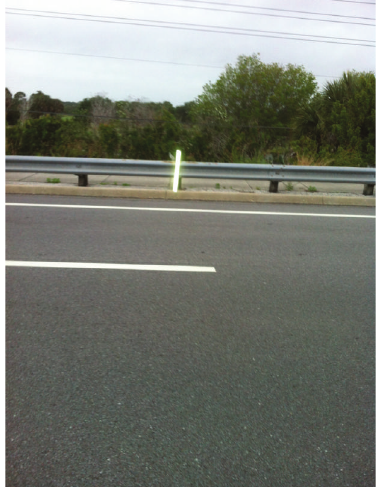
Figure 10: Starting point for the Belcher Road asphalt testing in Largo, Florida.